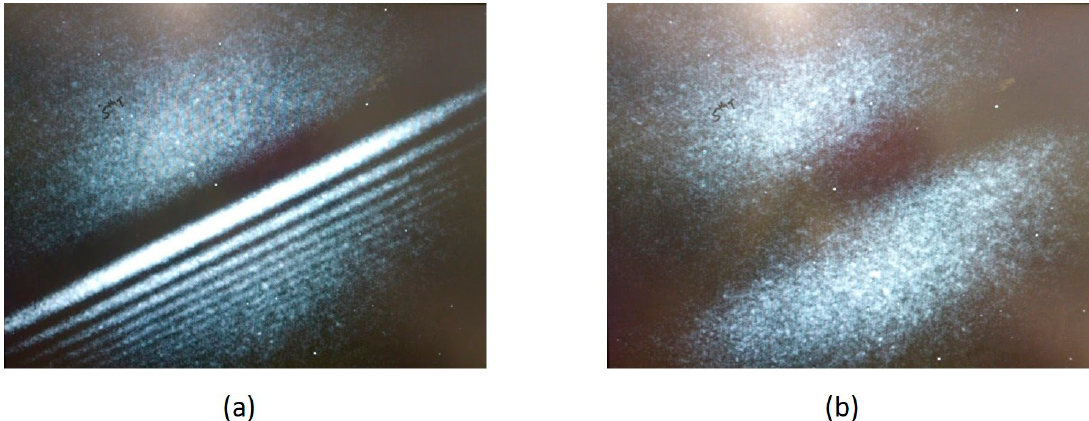
Figure 3. M-line pattern observed in the far-field image of the reflected light captured with a CCD camera in Kretschmann coupling configuration for ( a ) Bare multilayer; ( b ) Monolayer graphene.